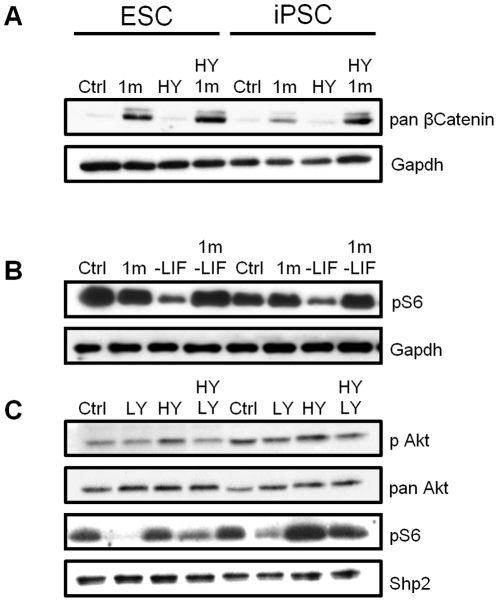
Effect of perturbation of key self-renewal signaling pathways in ESCs and iPSCs.ESCs and iPSCs were seeded in KO SR plus or minus LIF as indicated. After 24 hours 2 µM 1 m and 10% (v/v) Hyclone serum (HY) alone or together (A), 2 µM 1 m (B), 5 µM LY294002 and 10% (v/v) HY (C) or DMSO 1∶10000 (in all controls), were added. After a further 24 hours proteins were extracted and immunoblotting performed as indicated. Blots were stripped and re-probed with Gapdh, pan Akt or Shp2 antibodies to assess loading.